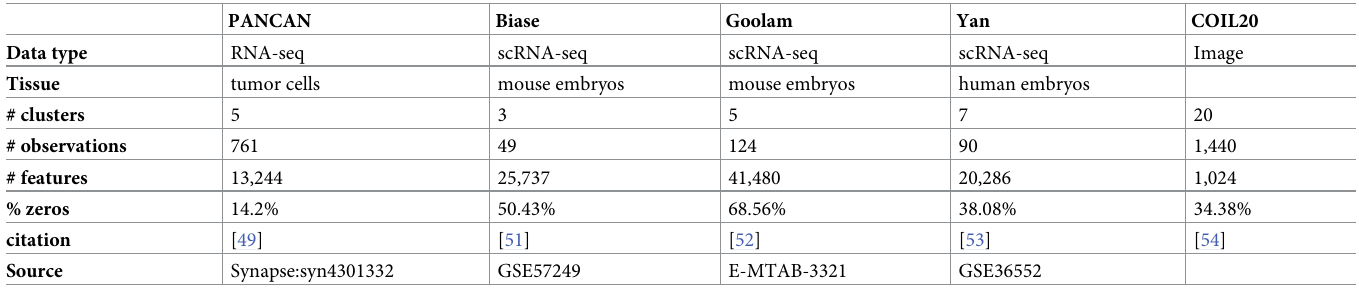
Table 1. Data sets used in empirical